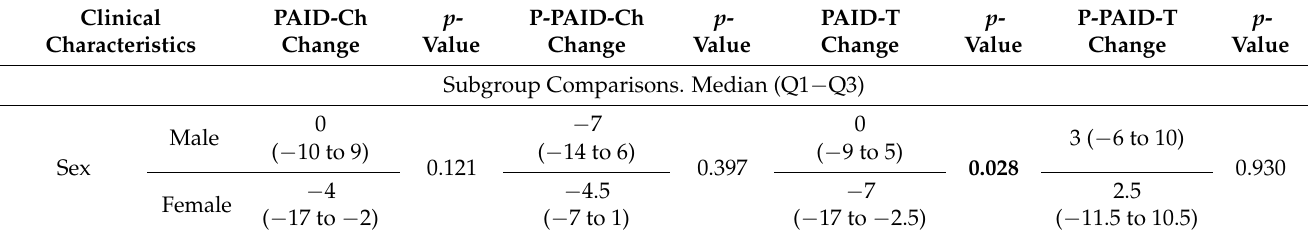
Table 2. Patients’ and parents’ change of PAID score (2nd PAID, i.e., during pandemic vs, 1st PAID, i.e., at baseline) in relation to clinical characteristics presented as medians (Q1–Q3) for subgroup comparisons and as R Spearman rank correlations for continuous variables. Pandemic-related difficulties and worries were assessed based on a semi-open questionnaire concerning the impact of the pandemic on diabetes care (attached in Supplementary Materials, Questionnaires). p -values for statistically-significant comparisons were